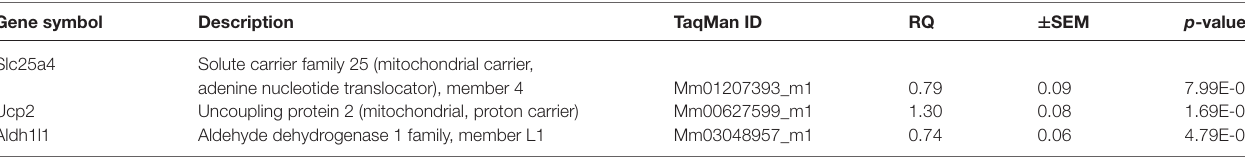
Supplementary Figure S1. The selection criteria of the 48 genes were based their known or supposed function in the regulation of the AVPV/MPOA and the estrous cycle. The official gene symbols and names are shown